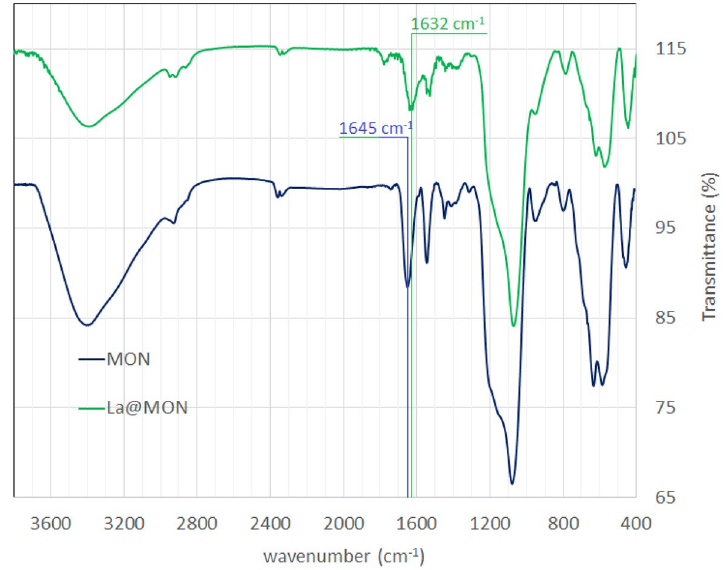
Figure 4. IR spectra of MON and La@MON.